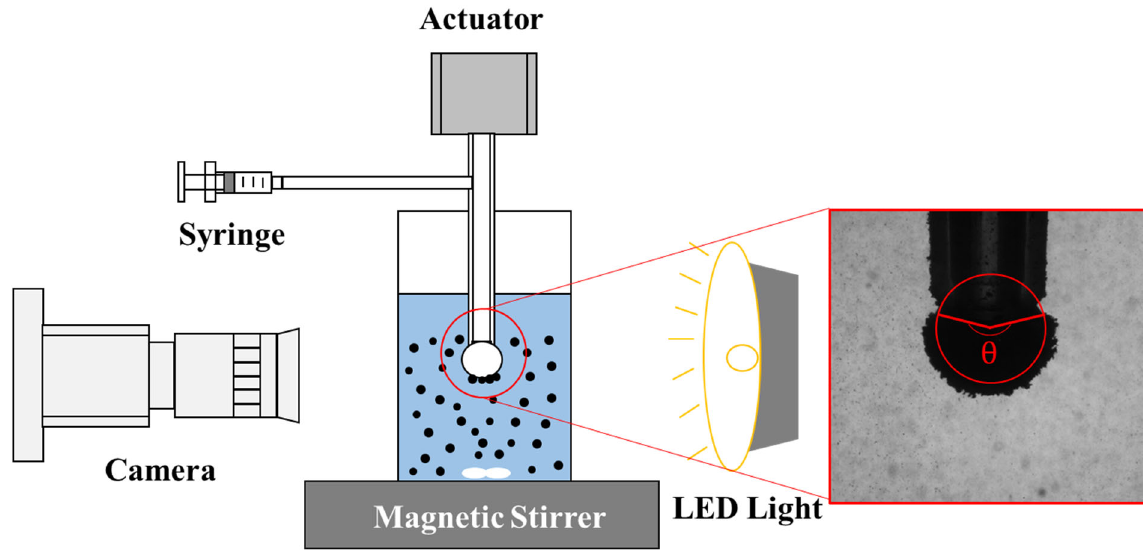
Figure 4. Schematic of bubble ‐ particle attachment test system.